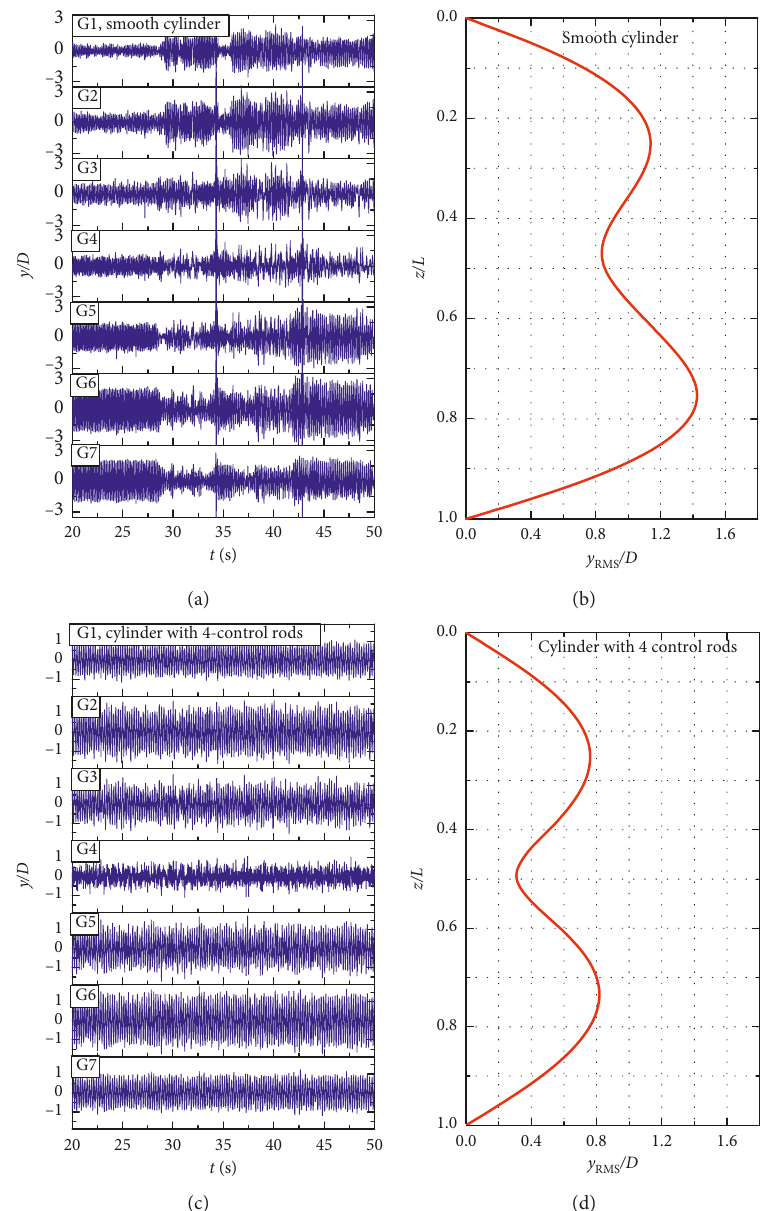
Figure 5: Displacement response characteristic of the vertical flexible cylinder ( α shedding at U 0.60m/s (the first column presents the time history of the nondimensional displacement ((a), (c)), the second column (cid:31) presents the spanwise evolutions of the RMS displacements ((b),